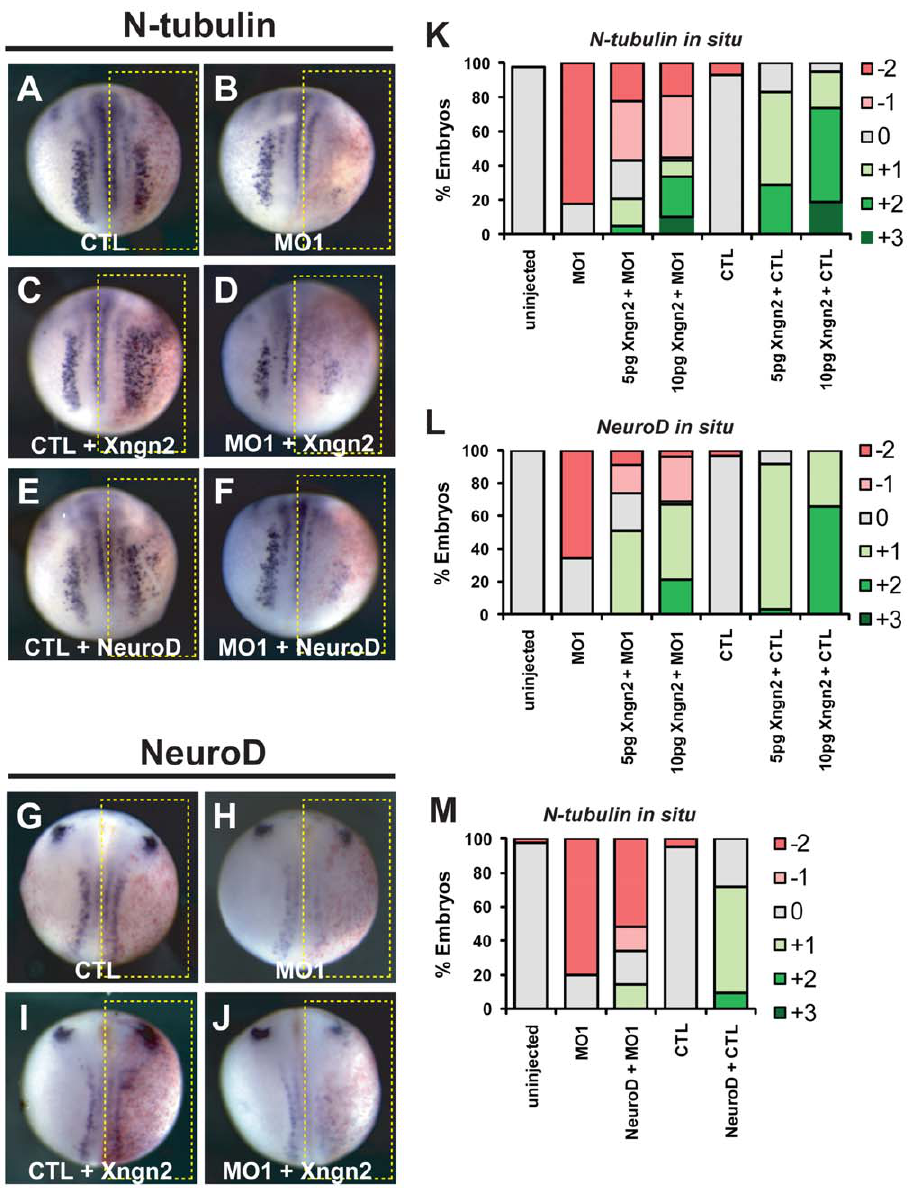
Figure 3. Xhes6 is required for the function of Xngn2 and NeuroD. Xngn2 or NeuroD mRNA was injected into one cell of two cell stage embryos with or without control (STD CTL) or Xhes6 (MO1) morpholinos. At neurula stage, embryos were analysed for expression of transcripts encoding N-tubulin (A 2 F) or NeuroD (G 2 J) by in situ hybridization. Injection of mRNAs encoding Xngn2 and NeuroD increases the number of primary neurons (C, E) but this effect is blocked by co-injection of the Xhes6 MO (D, F). Xhes6 is also required for Xngn2 to induce its target gene, NeuroD (J). K-L quantitation of phenotypes seen, scored as shown in Fig. S1; K, L effects of MO1 on Xngn2 induced expression of N-tubulin (K) and NeuroD (L) mRNA, M, effect of MO1 on N-tubulin mRNA expression induced by NeuroD. Full data on the frequency of phenotypes and the number of embryos analyzed is given in Table 2.